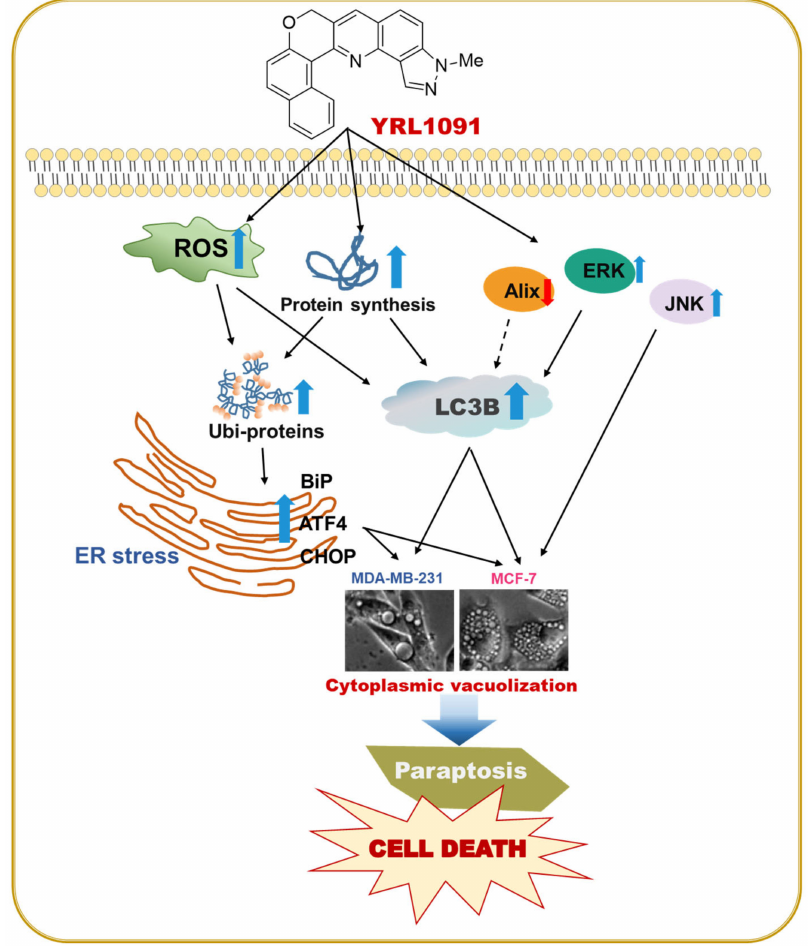
Figure 11. Schematic illustration of the molecular mechanisms of cell death triggered by YRL1091, leading to paraptotic cytotoxicity in MDA-MB-231 and MCF-7 breast cancer cells. The black arrows indicate pathways examined in this study, while the black broken arrow shows a pathway not exam- ined yet. ROS, reactive oxygen species; ER, endoplasmic reticulum; BiP, binding immunoglobulin protein; ATF4, activating transcription factor-4; CHOP, CCAAT-enhancer-binding protein homolo- gous protein; LC3B, microtubule-associated protein 1 light chain 3B; Alix, multifunctional adapter protein; ERK1/2, extracellular signal-regulated kinase 1/2; JNK, c-Jun N-terminal